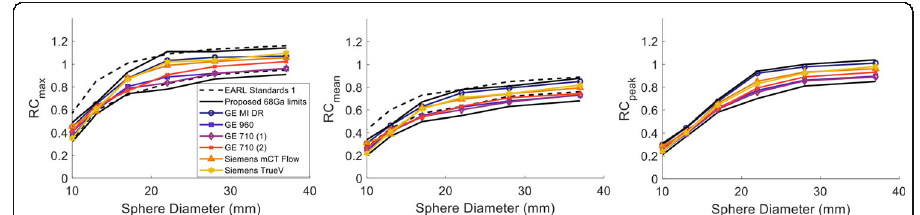
Fig. 3 RC max (left), RC mean (middle) and RC peak (right) for Gallium-68 from all six centres measured from the NEMA IQ phantom reconstructed with standard OSEM. The RCs (dashed black lines) for the EARL 1